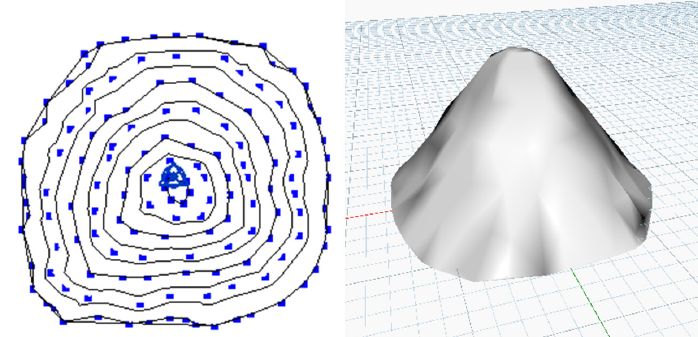
Figure 5. Updated model according to the acquired data.